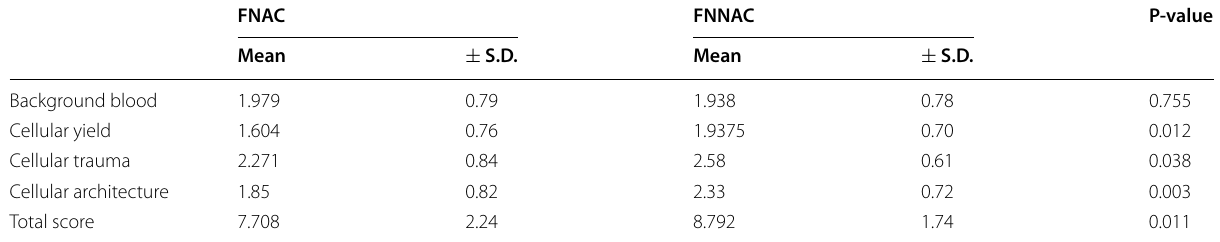
Table 3 Mean scores for sample quality